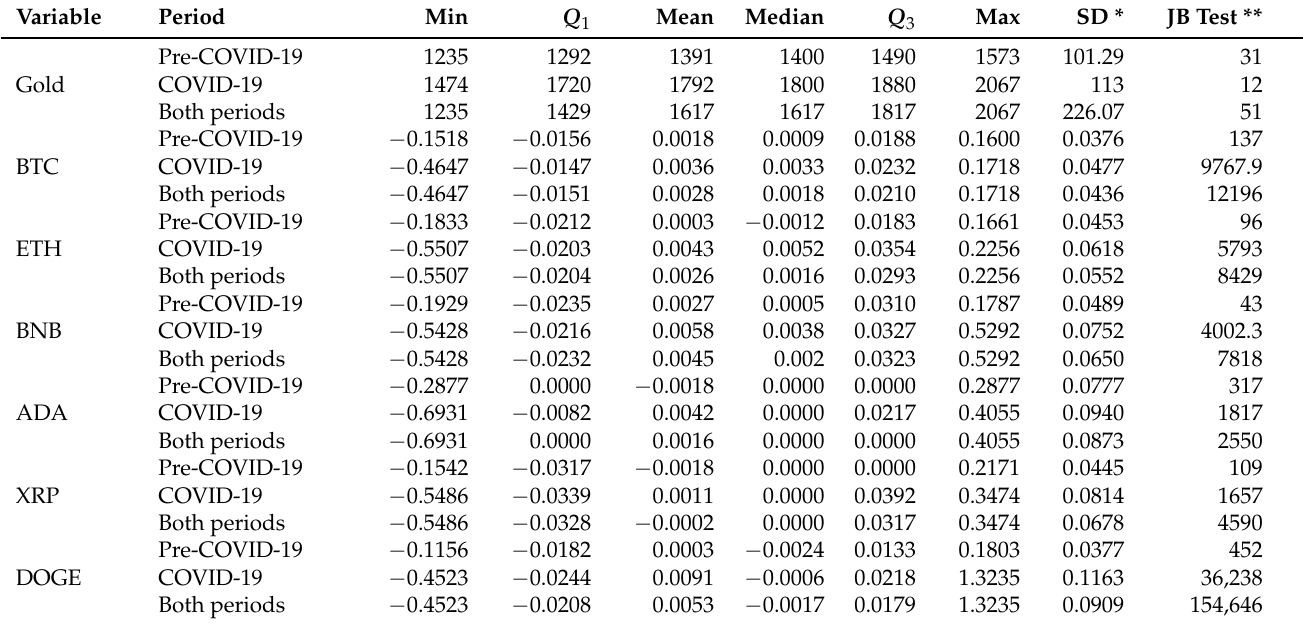
Table 2. Descriptive statistics and preliminary tests for data of gold price, cryptocurrency return, and COVID-19. Variable